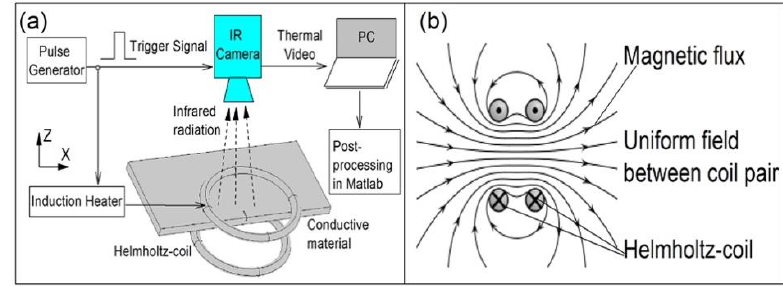
Figure 2. Proposed Helmholtz-coil configuration of ECPT. ( a ) Schematic diagram of Helmholtz-coil-based ECPT system. ( b ) Magnetic flux distribution with uniform field between two coils.